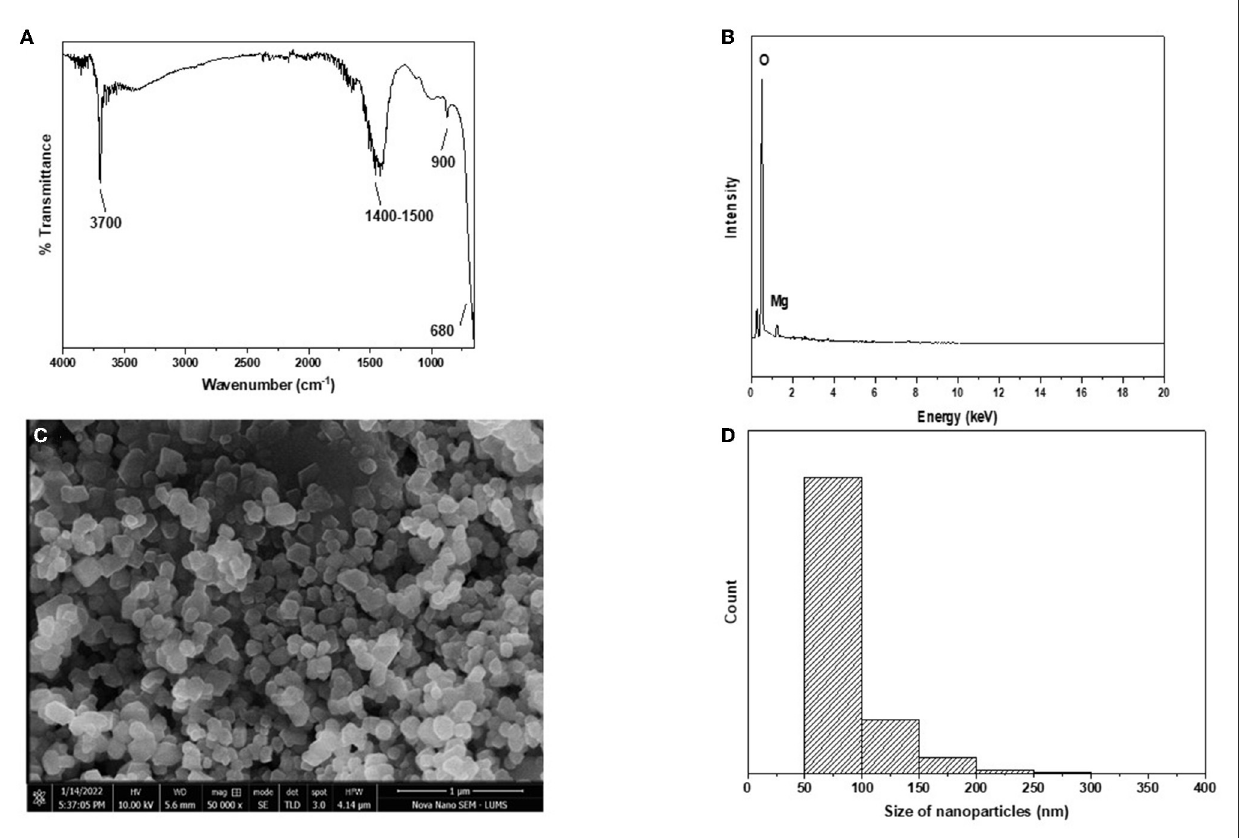
FIGURE2 (A–D) Characterization of MgO nanoparticles. (A) FTIR. (B) EDX. (C) STEM. (D) Size distribution